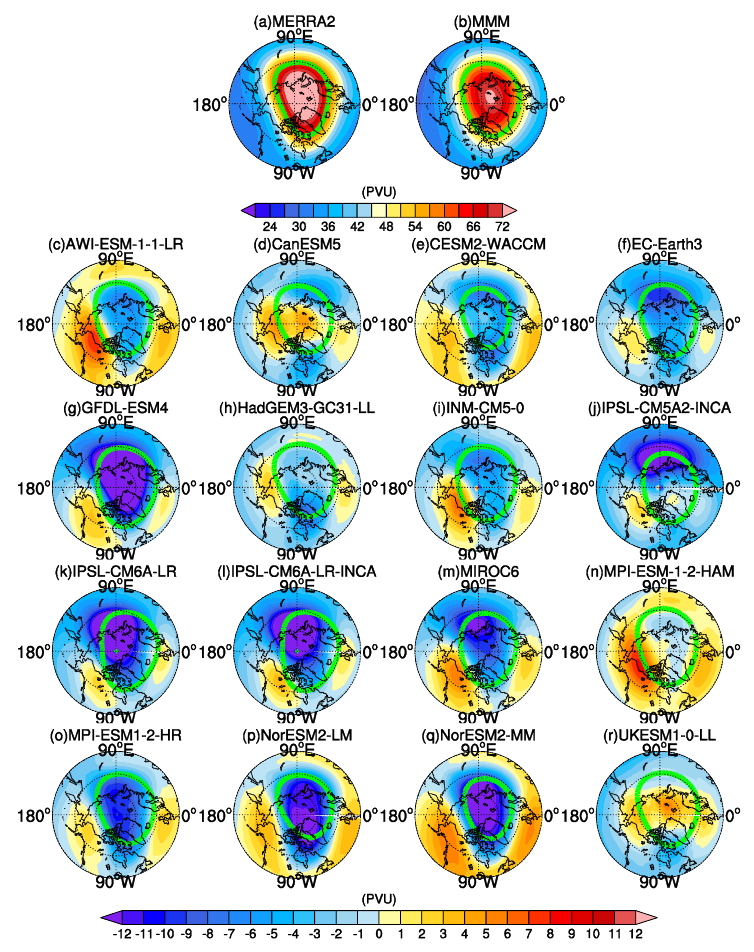
Figure 2. December – January – February (DJF) mean PV (unit: 1 PVU ， 1 PVU = 10 − 6 m 2 s − 1 K kg − 1 ) averaged over the isentropic levels between 430 – 600 K for the period 1980/81 – 2013/14 based on ( a ) MERRA2, ( b ) multi-model mean. ( c – r ) PV differences between individual CMIP6 model simula- tions and MERRA2. The green solid line represents the corresponding polar vortex edge in MERRA2 and/or CMIP6 model simulation.